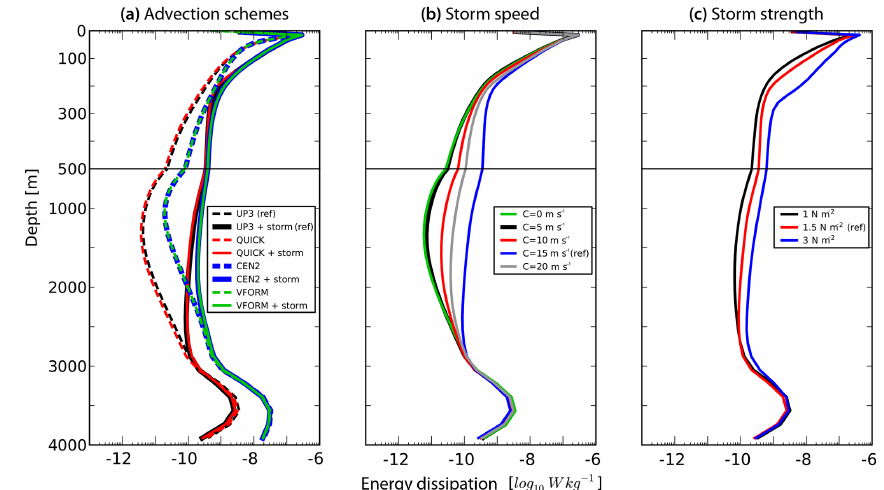
Figure 15. Sensitivity of energy dissipation ( ε ) profiles to numerics (a) , storm speed (b) and storm strength (c) . Experiments with (without) storms are shown with continuous (dashed) lines. The advective schemes tested in (a) are UP3 (reference), QUICK, flux-form second-order centered advection scheme (CEN2) and a vector form advection scheme (VFORM). The profiles of the latter two (blue and green colors) are confounded in panel (a) . Dissipation induced by storms traveling at different speeds is tested in (c) for propagation speeds of 0, 5, 10, 15 and 20ms − 1 . In these experiments the duration and the power of the storms are the same as in the reference experiment (for which the storm propagation speed is 15ms − 1 ) . In (d) , the sensitivity to the storm strength is tested by comparing experiments with maximum wind-stress values equal to 1, 1.5 (reference) and 3Nm − 2 . All the sensitivity experiments are run at 2km horizontal resolution. They start from the same initial condition equilibrated without storms, and they are run for 3 years. Profile are built using 5-day snapshots of the entire domain for the last 2 years of the